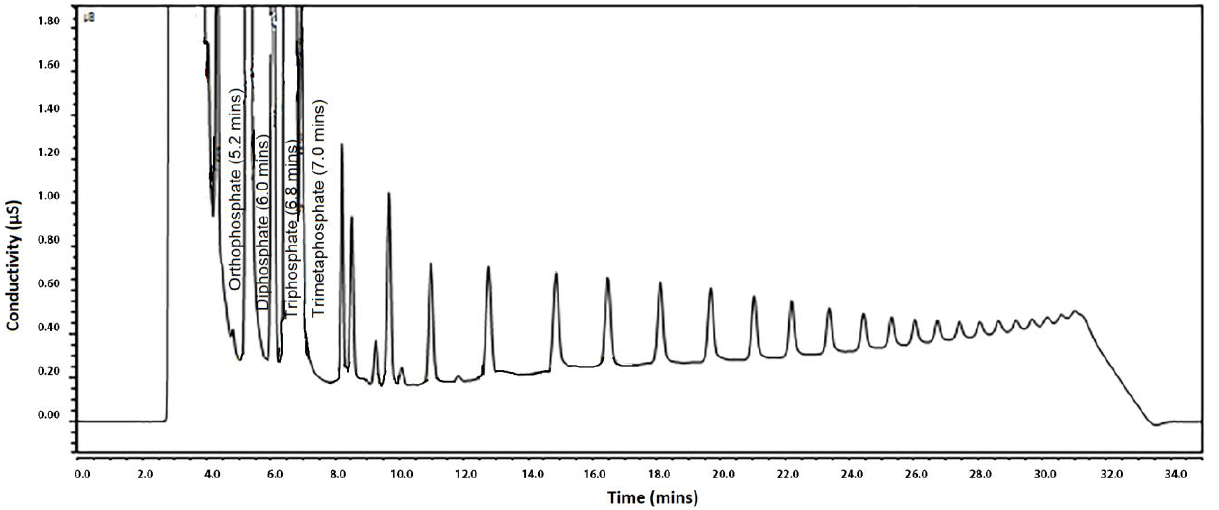
Figure 3. Chromatogram of a frozen shrimp sample with (poly)phosphates declared on